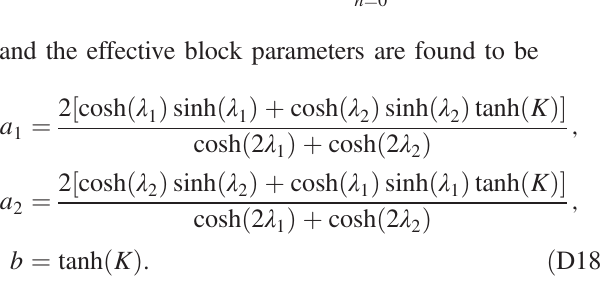
FIG. 10. Logarithmic plot showing the exponential decay of the two-point correlator K 0 2 ð l Þ with distance l at K ¼ 0 . 1 . The blue data points represent the results obtained from the cumulant expansion of the RSMI-favored solution up to tenth order, while the yellow line shows the exponential decay with decay length obtained from the first two points. For small K , where the cumulant expansion is expected to be accurate, the two-point correlator decays exponentially. symmetries with respect to the diagonals). Starting from θ ¼ 0 at the peak, the trajectory traces out the lower branch of the curves in Figs. 5(a) and 5(b) reaching the lowest point at θ ¼ π = 4 , before turning around and exactly retracing the trajectory toward the peak at θ ¼ π = 2 . The trajectory then moves on the upper branch reaching the uppermost point at θ ¼ 3 π = 4 and retracing toward the peak again at θ ¼ π = 2 . This exact retracing is due to two independent Z 2 symmetries: that of the Ising model and that of the mutual information. Since Z 2 × Z 2 is not isomorphic to Z 4 , we do not have a fourfold symmetry